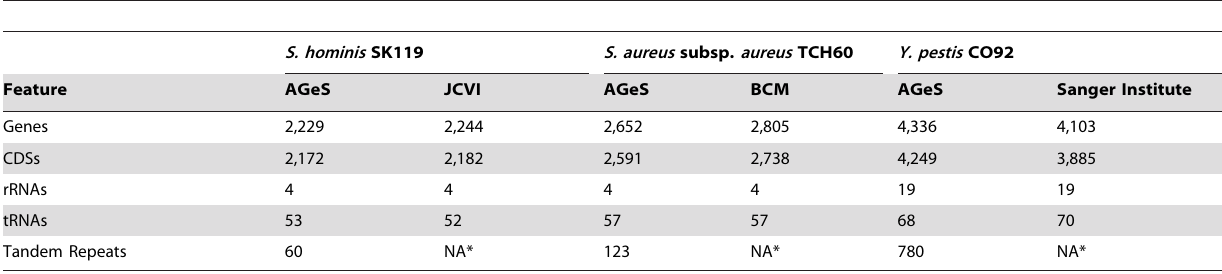
Table 2. Summary of genomic features predicted by AGeS and other annotation methods for two draft genomes and one completed genome.